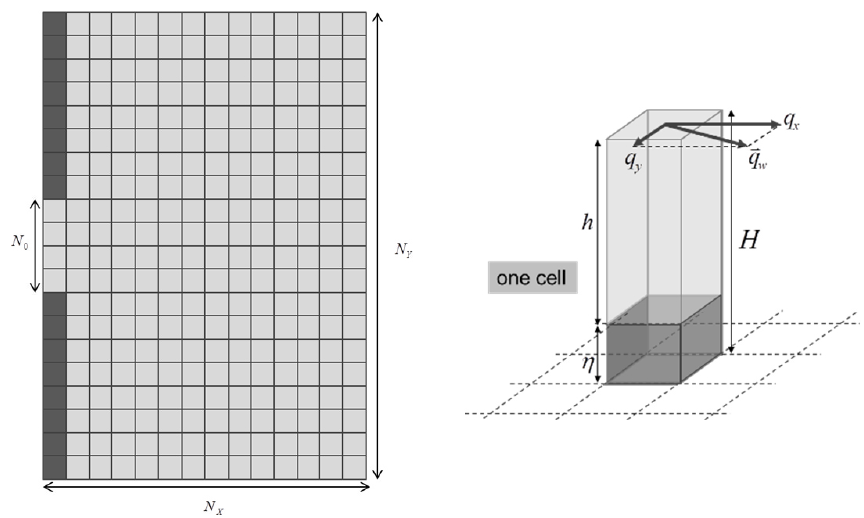
Figure 2. Diagram of the lattice grid and the primary values at each cell (water unit discharge, water surface elevation and bed elevation). Note that the total number of cells is reduced for the